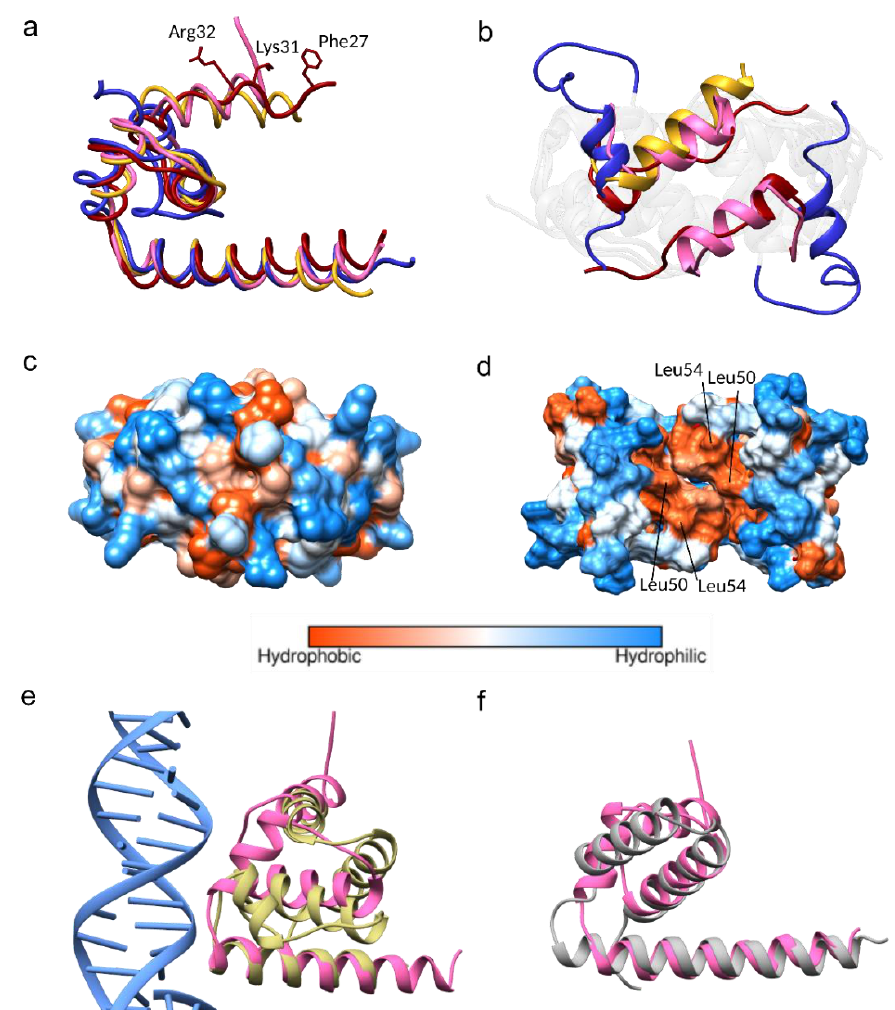
Figure 3. Comparison of the JEV, West Nile virus (WNV), dengue virus (DENV), and Zika virus (ZIKV) capsid proteins. ( a ) Superimposition of monomers of the WNV capsid (PDB: 1SFK) in gold, the DENV capsid (1R6R) in blue, and the ZIKV in red (5YGH) to the JEV capsid in pink. ( b ) Superposition of the α1 - α1’ of the WNV, DENV, ZIKV, and JEV from the top view. Note that helix -1 in chain B of the WNV capsid is missing. ( c ) Hydrophobic surface of the JEV capsid showing the closed position and ( d ) similar view of the DENV capsid showing the opened position. ( e , f ) Structural homolog superimposition ( e ) The JEV capsid in pink is superimposed on transcription factor IIB (TFIIB) subunit of the transcription initiation complex (PDB 5FYW) and ( f ) human CNOT1 (PDB 4CQO).